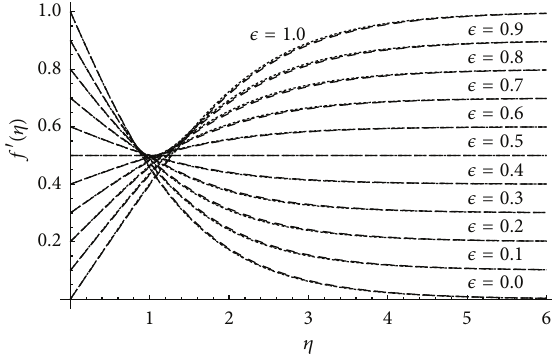
Figure 4: The fluid velocity for the class of the Falkner-Skan prob- lem at different values of 𝜖 using 11, 13, and 15 terms of the current